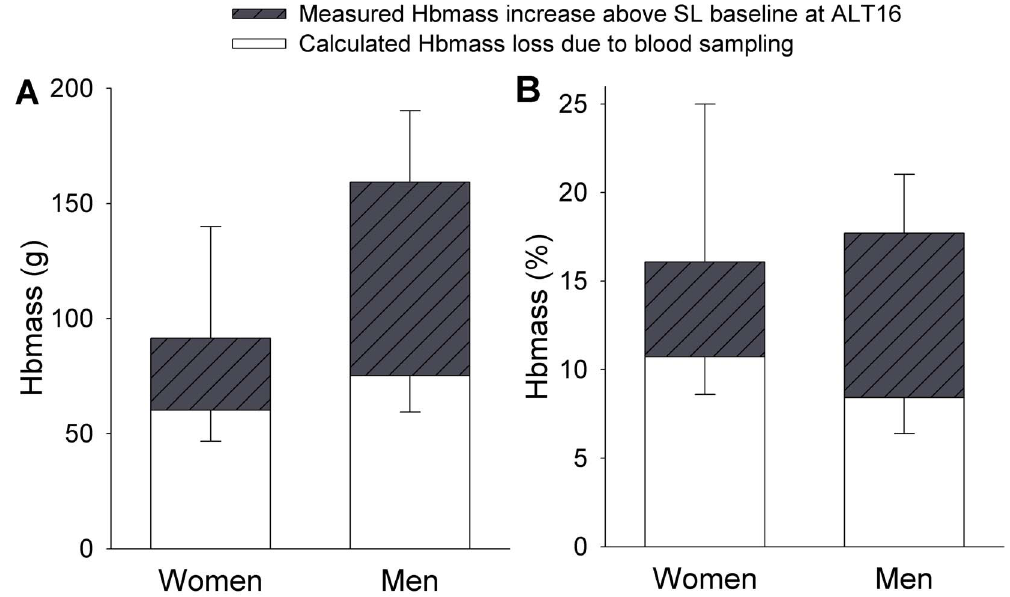
Figure 3. Estimate of the increase in hemoglobin mass produced during 16 days high altitude acclimatization determined from the measured Hbmass increase above sea level baseline plus the calculated Hbmass loss due to blood sampling. Panel A represents the absolute increase in Hbmass (g) produced. Panel B represents the percent increase in Hbmass produced. Data are presented as mean 6 SD. Upward SD bars represent the SD of the increase in Hbmass measured above baseline and the downward SD bars represent the SD of calculated Hbmass loss due to blood sampling.